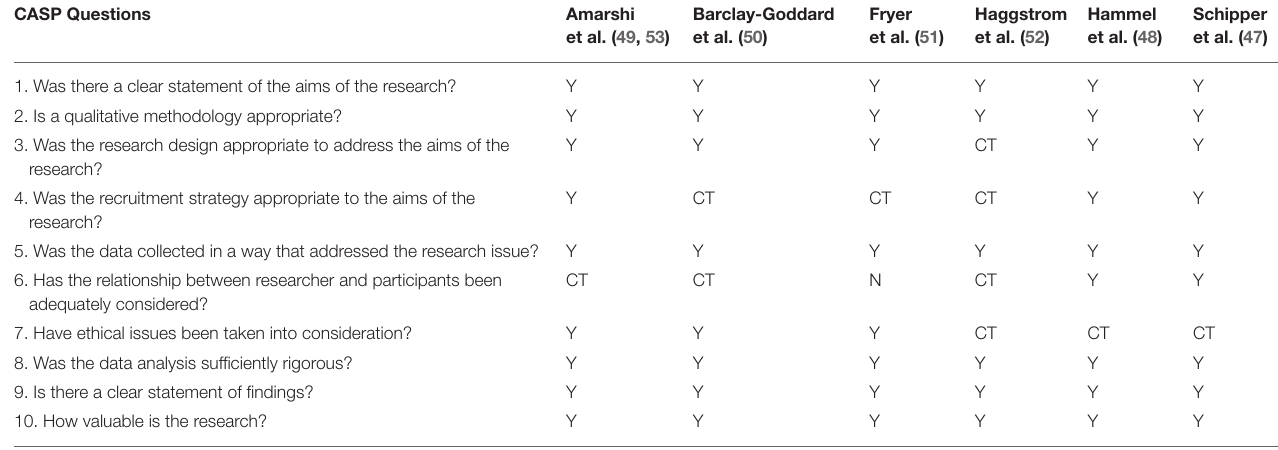
TABLE 3 | CASP Quality appraisal for all articles.